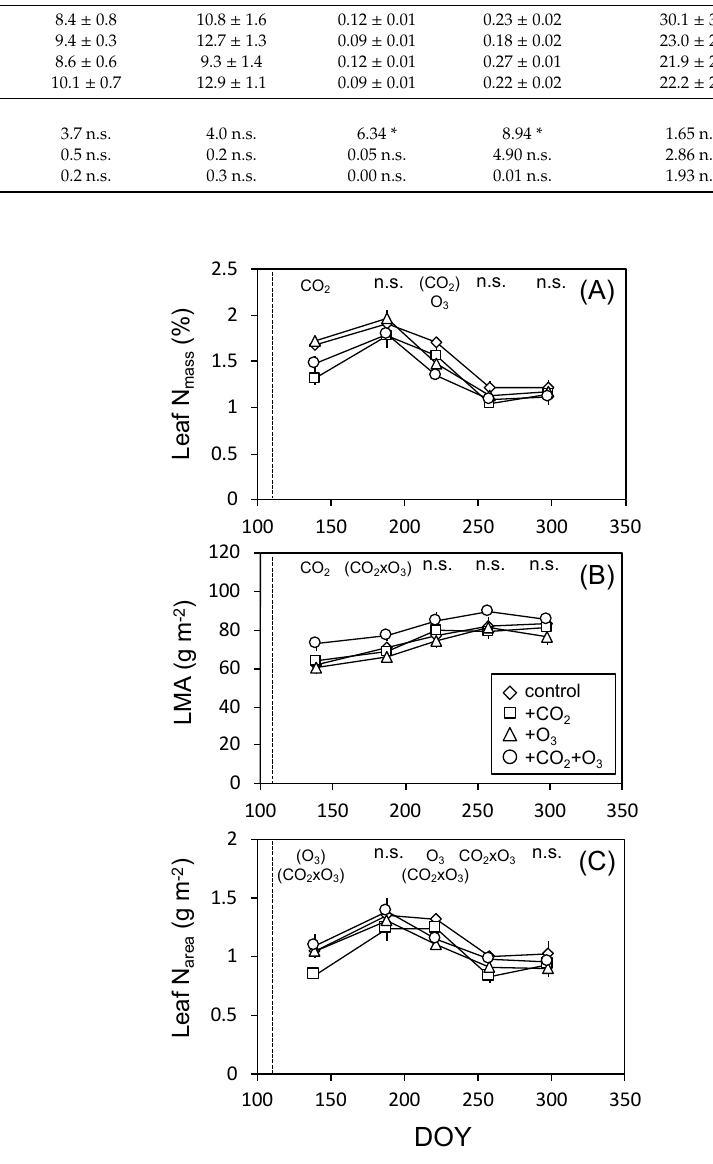
Figure 2. Seasonal change in the leaf N concentration (leaf N mass ) ( A ), leaf mass per area (LMA) ( B ), and area-based leaf N content (leaf N mass ) ( C ) in the first flush leaves of F. crenata seedlings grown under the CO 2 and O 3 treatment combinations at each ambient CO 2 level (380 and 550 µmol mol − 1 ). The format of these figures is the same as in Figure 1. Table 1. Light-saturated net CO 2 assimilation rate ( A growth-CO2 ) and stomatal conductance ( g sw-growth-CO2 ) in May and July at each ambient CO 2 level (380 and 550 µmol mol − 1 ), the maximum rate of carboxylation at 25 °C ( V cmax25 ) in August, and the maximum PS II photochemical efficiency ( F v / F m ) at predawn in October in the first flush leaves of F. crenata grown under ambient air (control), elevated CO 2 (+CO 2 ), elevated O 3 (+O 3 ), and the combination of elevated CO 2 and O 3 (+CO 2 +O 3 ). Values at upper half lines are means ± SE of three replicates for each treatment. F values of analysis of variance (ANOVA) to test the main effects of CO 2 , O 3 , and their interactions are also shown at lower half lines. Significant effects are indicated by *; p < 0.05, and n.s.; non-significant. Treatments